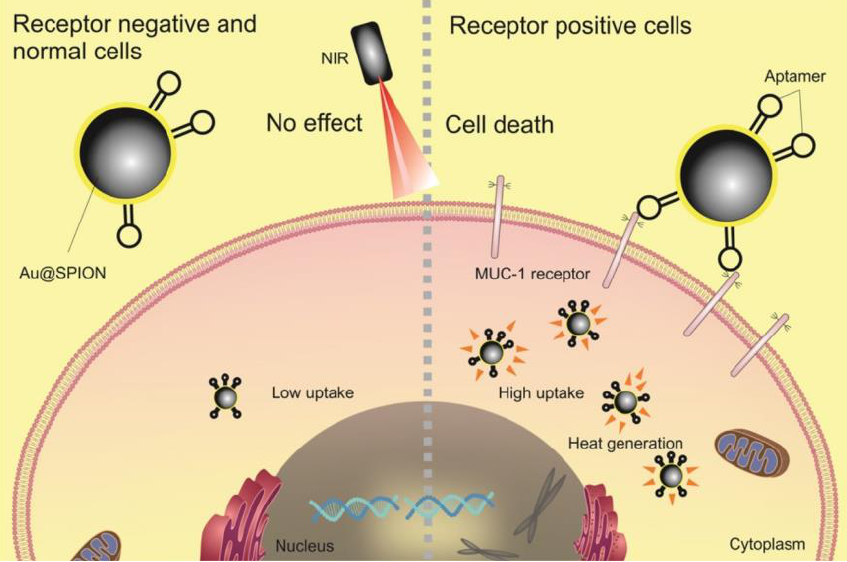
Figure 4. MUC-1 aptamer-targeted gold-coated superparamagnetic iron oxide nanoparticles for PTT and MRI of colorectal cancer. Reprinted with permission from Ref. [123]. Copyright 2022, Elsevier.